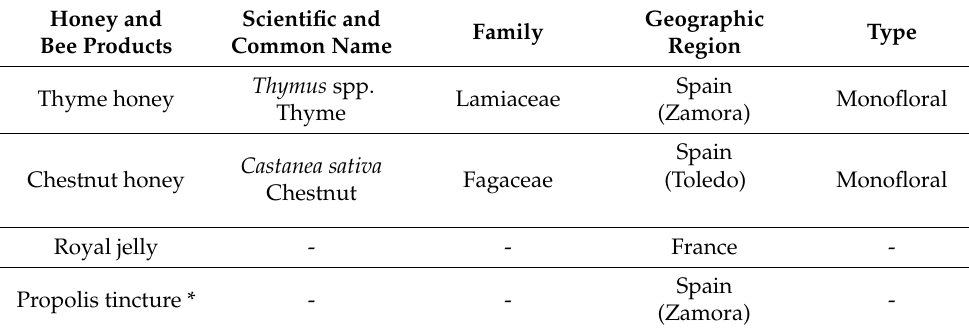
Table 1. Honey and bee products samples.